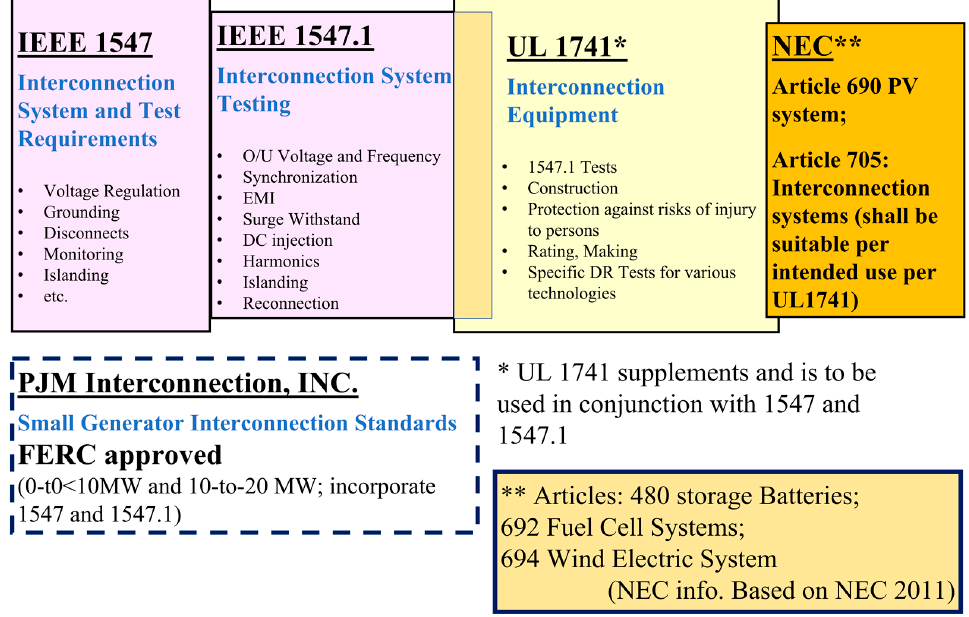
Figure 4. IEEE 1547 standards use in the United States.